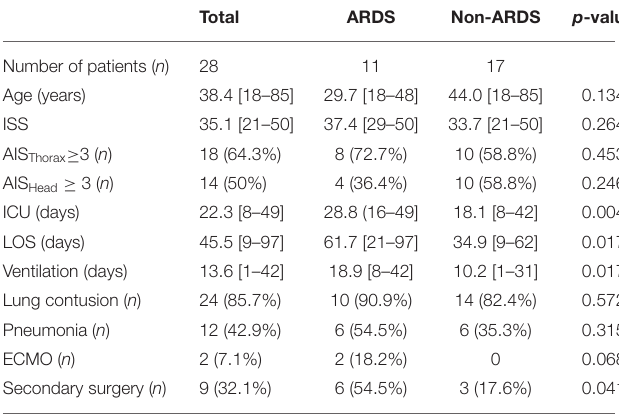
TABLE 1 | Demographic data.